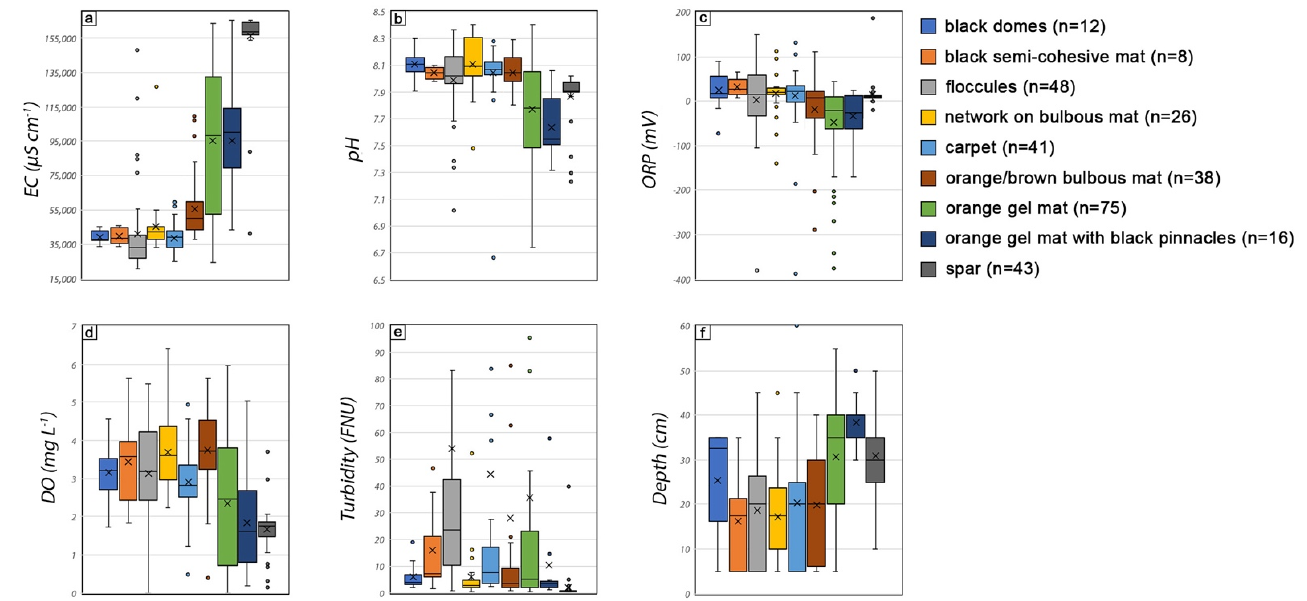
Figure 7. Box and whisker plots showing bottom type with corresponding ( a ) electrical conductivity (EC, µS cm − 1 ), ( b ) pH, ( c ) oxidation reduction potential (ORP, mV), ( d ) dissolved oxygen (DO, mg L − 1 ), ( e ) depth (cm), and ( f ) turbidity (FNU) measurements as recorded in March 2019. DO —The smallest interquartile range in DO was observed in spar bottom type (n = 43; Q1: 1.47 mg L − 1 , Q3: 1.87 mg L − 1 ; IQR: 0.40 mg L − 1 ). The largest interquartile range was observed in orange gel mat (n = 75; Q1: 0.73 mg L − 1 , Q3: 3.81 mg L − 1 ; IQR: 3.08 mg L − 1 ). Spar bottom type had the lowest mean DO concentration (n = 43; 1.66 mg L − 1 ), whereas the lowest median DO concentration was recorded for orange gel mat with black pinnacles bot- tom type (n = 16; 1.63 mg L − 1 ). Orange–brown bulbous mat (n = 16) had the highest mean DO concentration (3.73 mg L − 1 ), and the highest median value (3.73 mg L − 1 ) (Figure